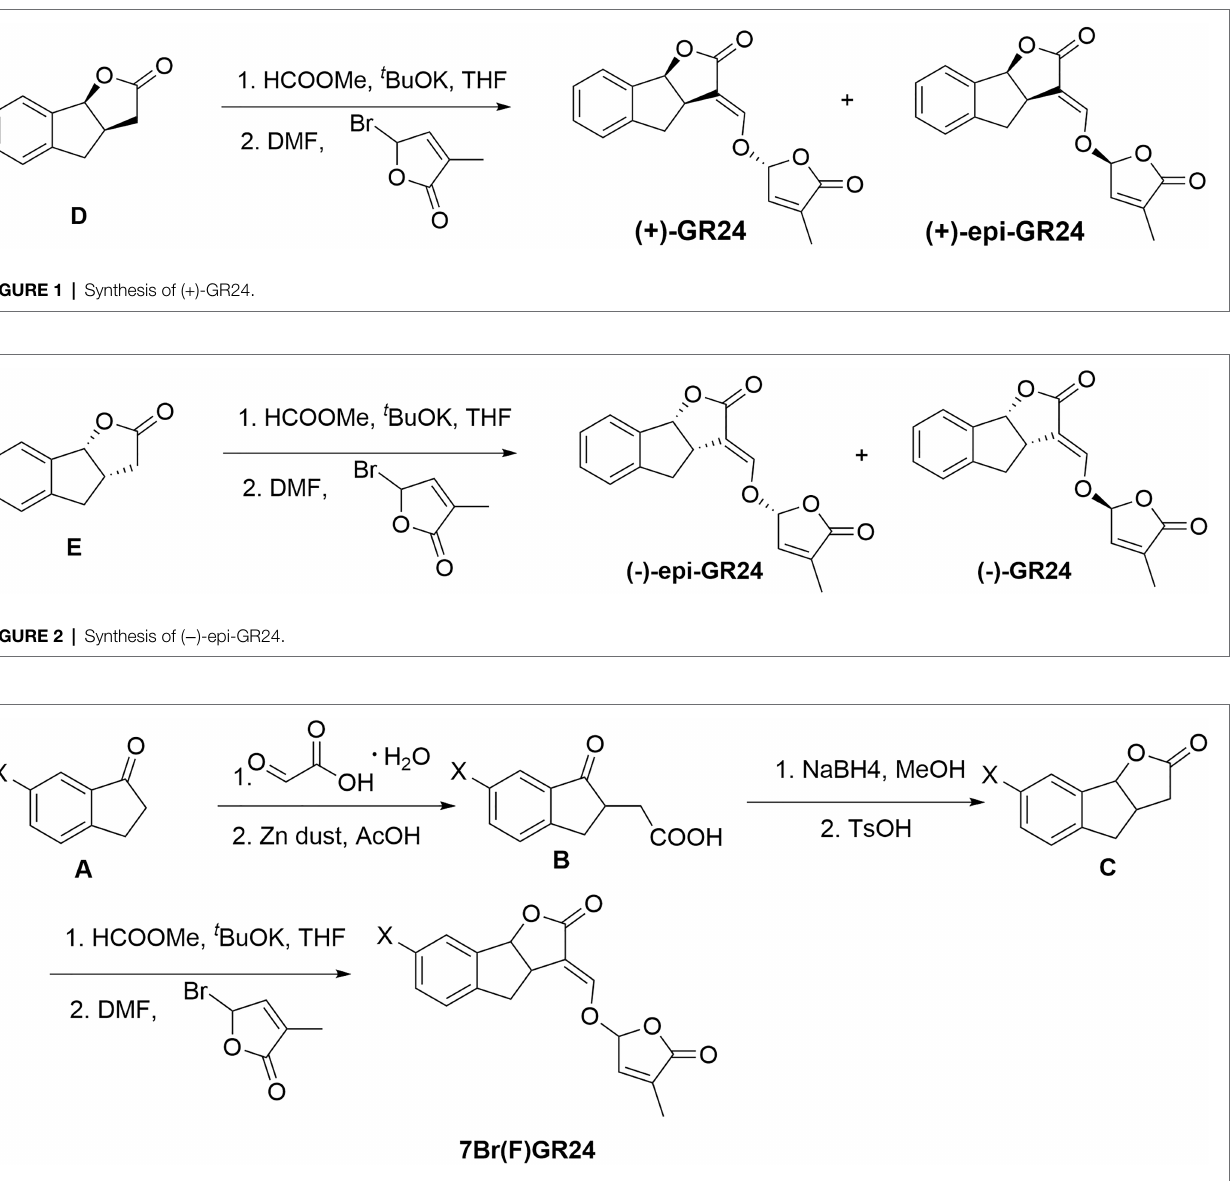
FIGURE 3 | Synthesis of 7-bromo-GR24 (7BrGR24) and 7-fluoro-GR24 (7FGR24),